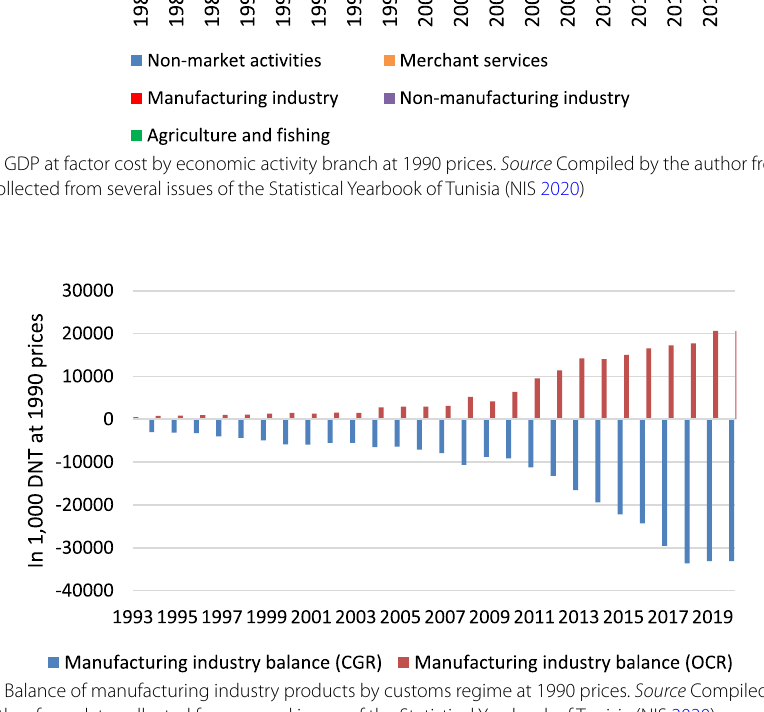
Fig. 5 Balance of manufacturing industry products by customs regime at 1990 prices. Source Compiled by the author from data collected from several issues of the Statistical Yearbook of Tunisia (NIS